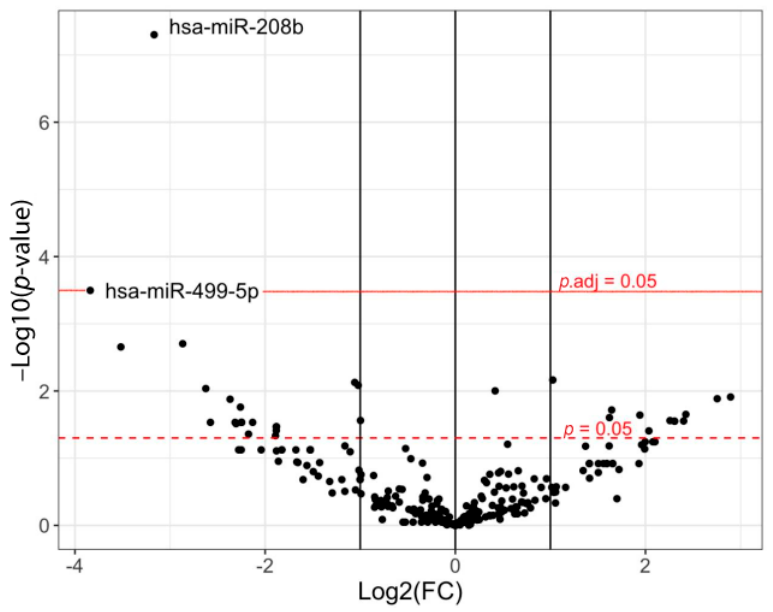
Figure 1. The comparison of the profiles of circulating miRNAs in patients with HCM ( n = 9) and controls ( n = 6). On the graph, the X-axis represents the values of the fold change (FC) in miRNA levels, the Y-axis represents the p values, all in a logarithmic scale. The dotted line indicates threshold for statistical significance p = 0.05; solid line—threshold for statistical significance adjusted p -value ( p .adj) = 0.05; dots—miRNAs.